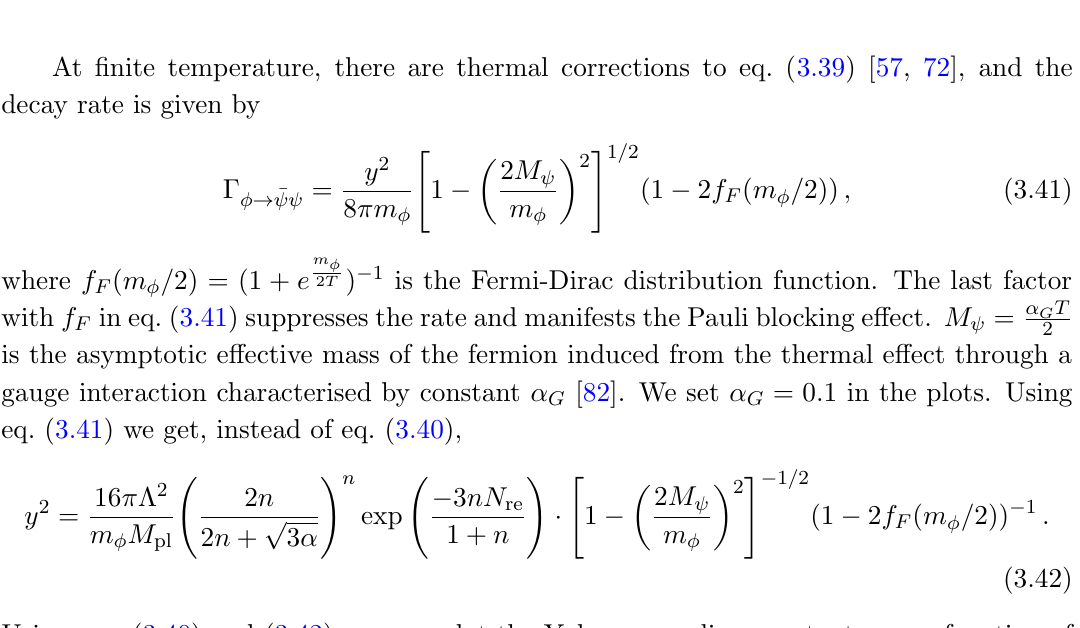
Figure 12. The same as (cid:12)gure 6, but for Yukawa interaction y(cid:30) (cid:22) . The numbers over disks denote log y computed using eq. 10